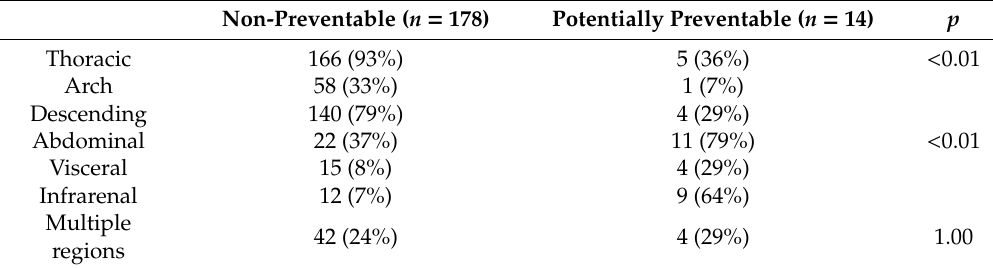
Table 3. Location of aortic injury by